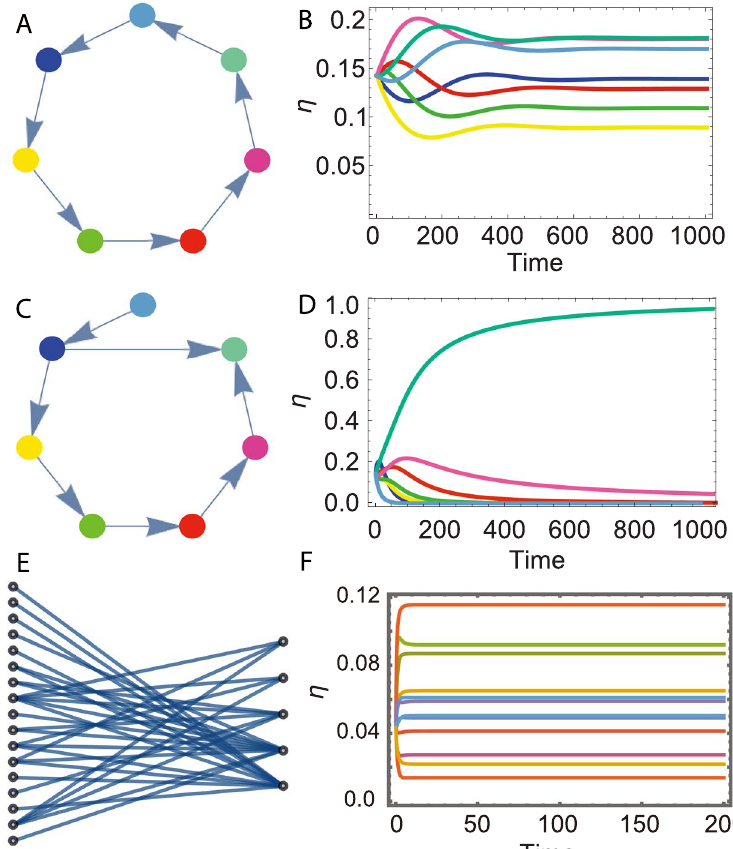
Figure 3. The results of the mean field predictions. ( A ) Species interaction network for 7 species where each = 1,  = 1. ( B ) Time evolution of the populations of the 7 species i has one mutualistic partner j , i.e. M ij = 1,  1 2 species as predicted by the mean field dynamics Eq. (2). ( C ) Species interaction network for 7 species where one species is not helped by any species and the iterative pruning process, as described in the main text, leads to a cascade of extinctions. ( D ) As the time evolution of the mean field Eq. (2), only one species dominates the community. ( E ) Nested structure for fruit eating birds community in Mexico 39 . ( F ) All species coexist, as predicted by our theoretical framework. In the ordinate axis use the notation η and not η